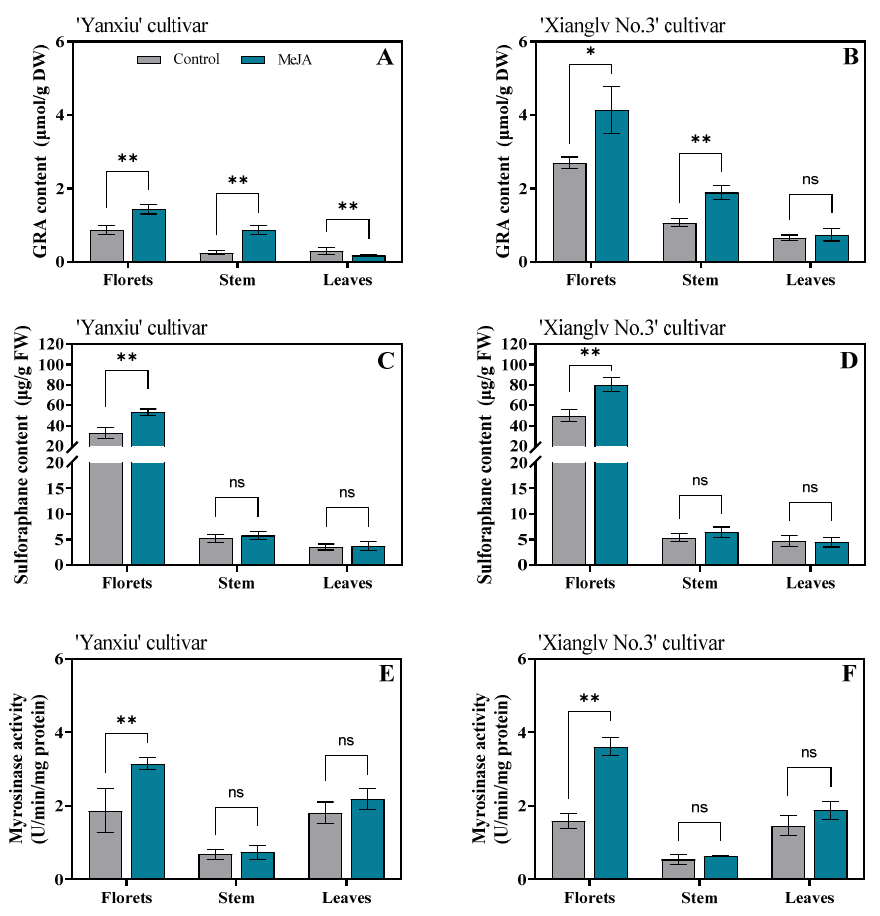
Figure 2. Effects of MeJA on GRA content( A , B ), sulforaphane content ( C , D ), and myrosinase activity ( E , F ) in broccoli florets, stem, and leaves. GRA: Glucoraphanin, DW: dry weight, FW, fresh weight. Control: the plants were sprayed with distilled water, MeJA: the plants were sprayed with 40 µ mol/L MeJA. The data are displayed with the mean ± SD of three replications. Values with ns, * and ** are significantly different at p > 0.05, p < 0.05 and p < 0.01.